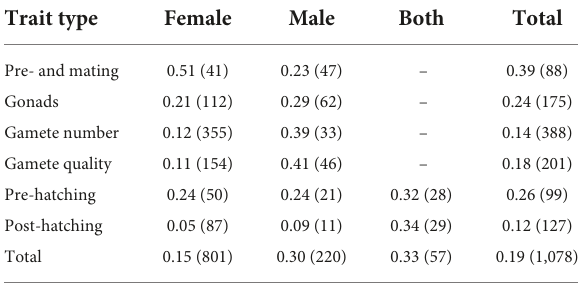
TABLE 1 Distribution of the reproductive senescence records across different climatic and aquatic environments.